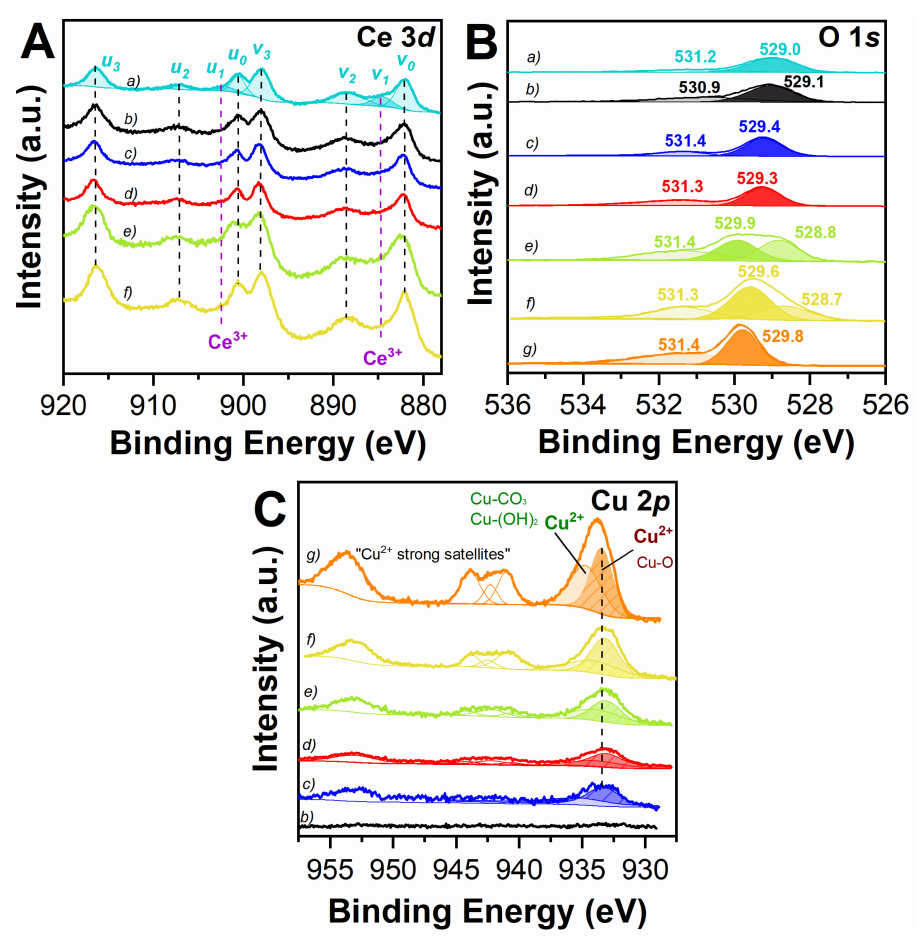
Figure 5. XP spectra of (a) CeO 2 , (b) 5%CuCeO x , (c) 10%CuCeO x , (d) 20%CuCeO x , (e) 30%CuCeO x , (f) 60%CuCeO x and (g) CuO in the ( A ) Ce 3 d , ( B ) O 1 s and ( C ) Cu 2 p